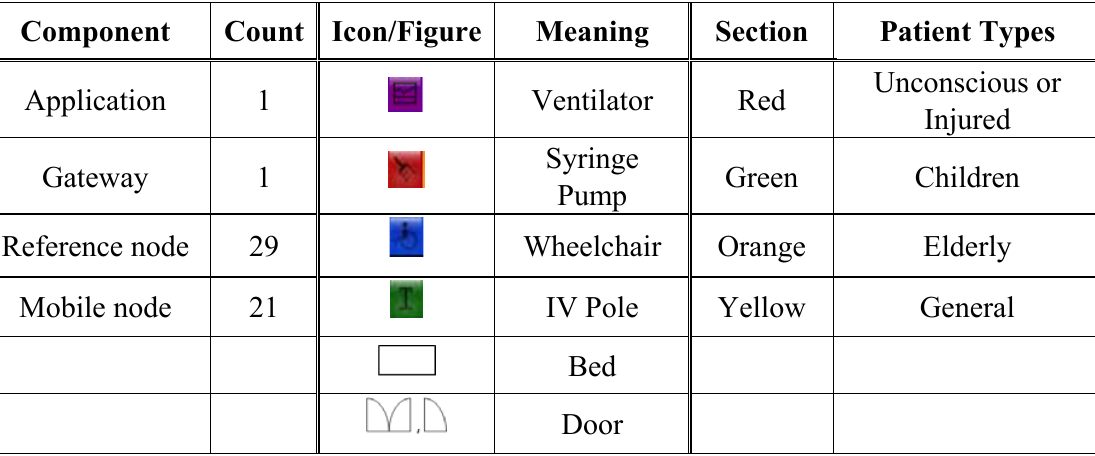
Table 3. Component and legend of the mobile asset tracking